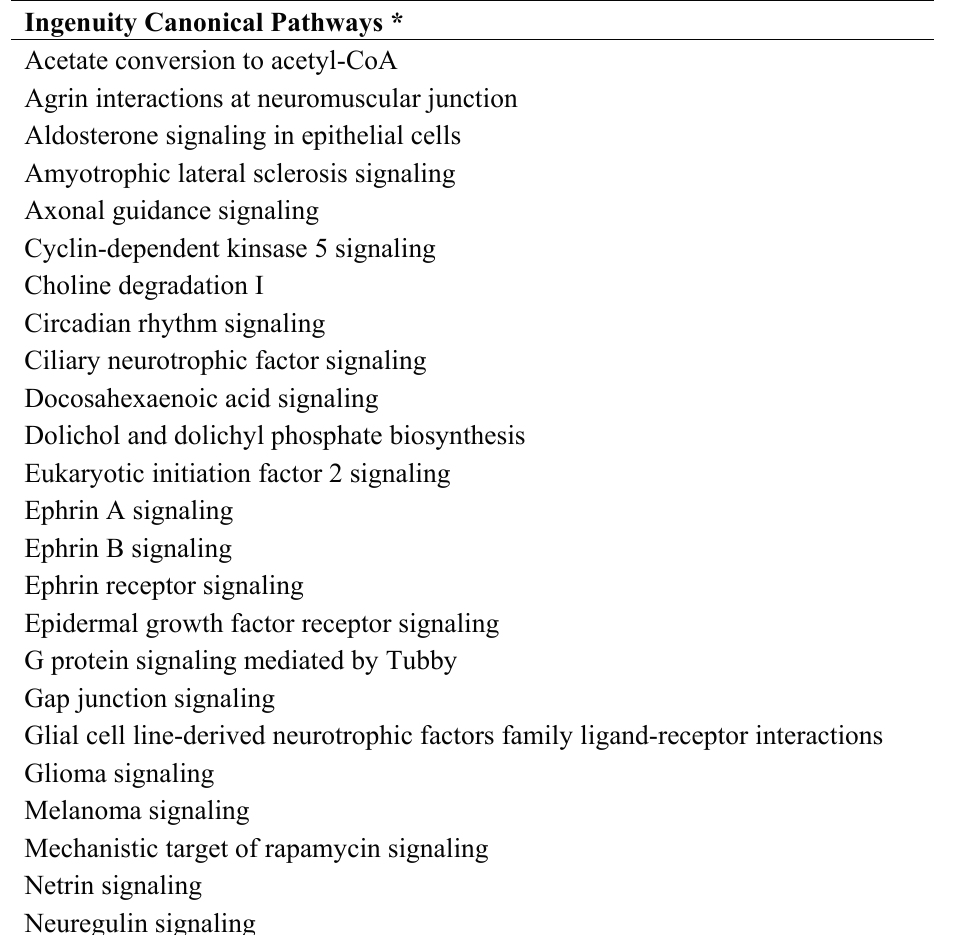
Table 3. Common neurological pathways in both MBD5 and RAI1 knockdown SH-SY5Y